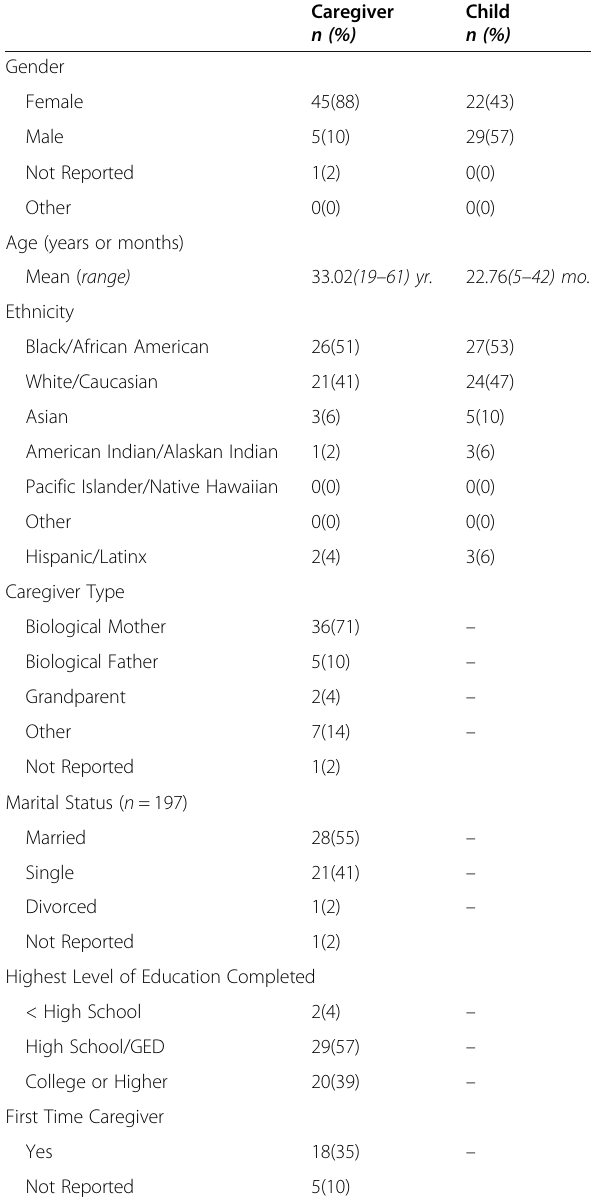
Table 1 Participant Demographics ( n =